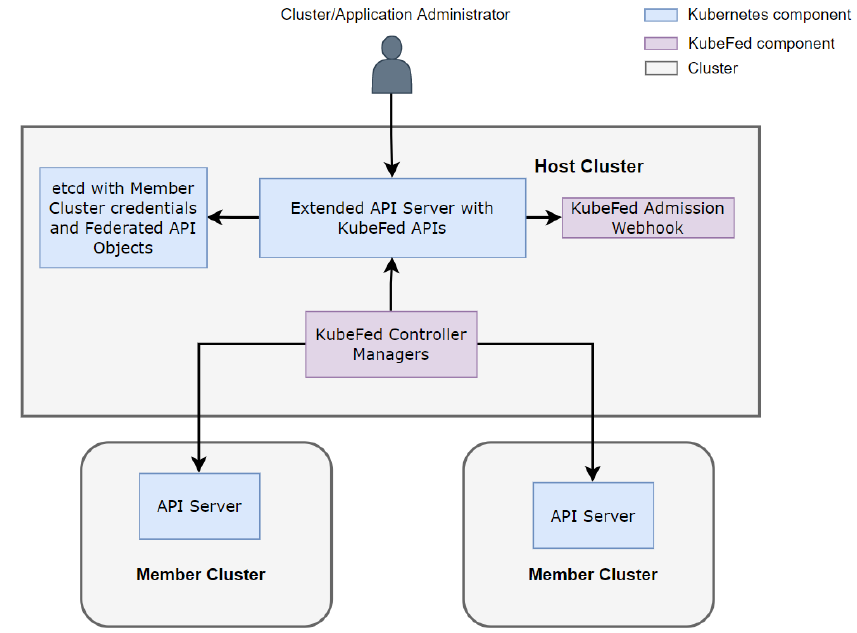
Figure 2. Cluster Federation based on KubeFed